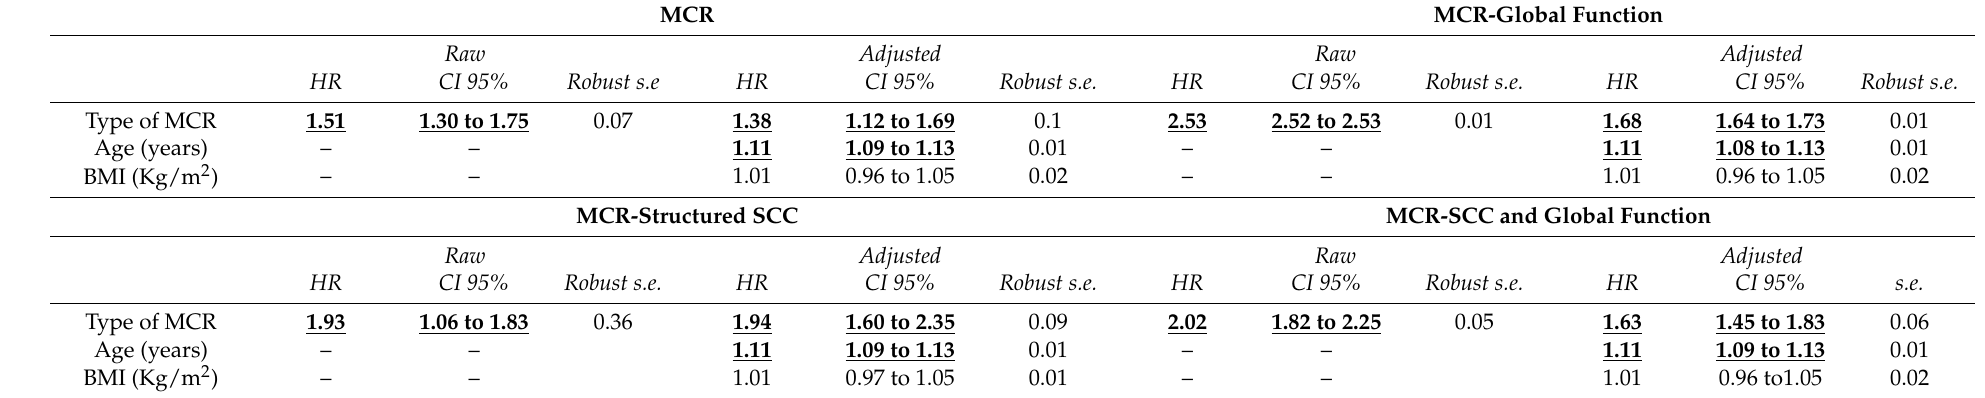
Table 4. Generalized estimating equations for clustered survival data on